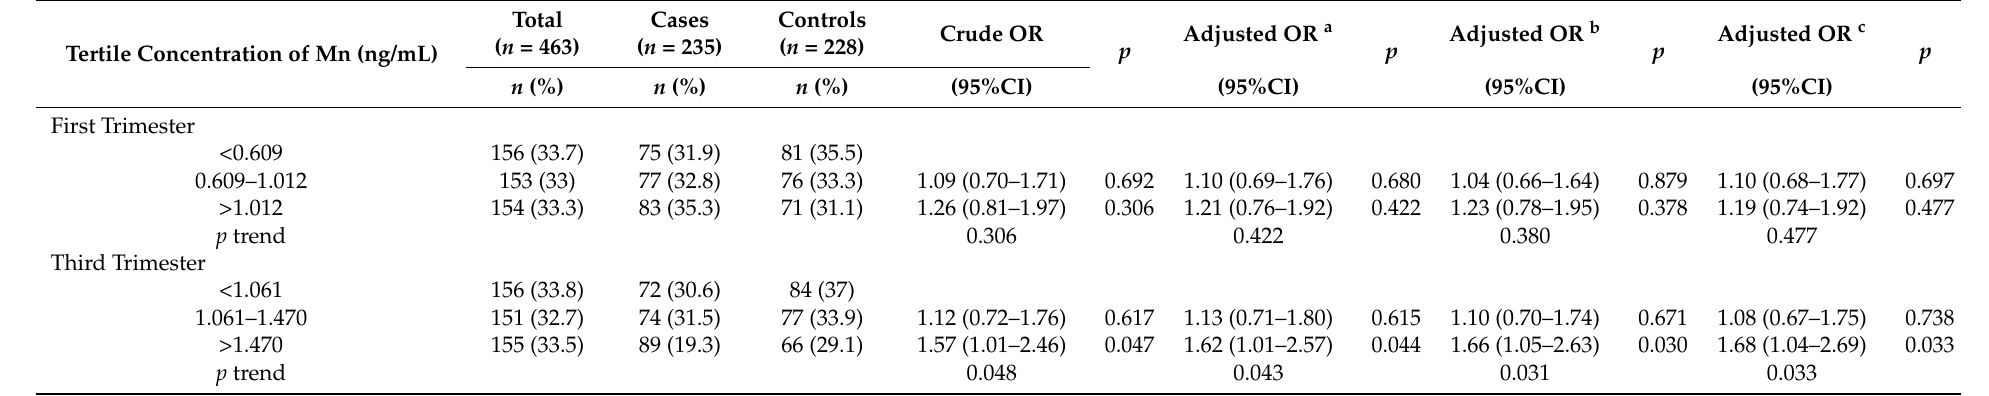
Table 7. Sensitivity